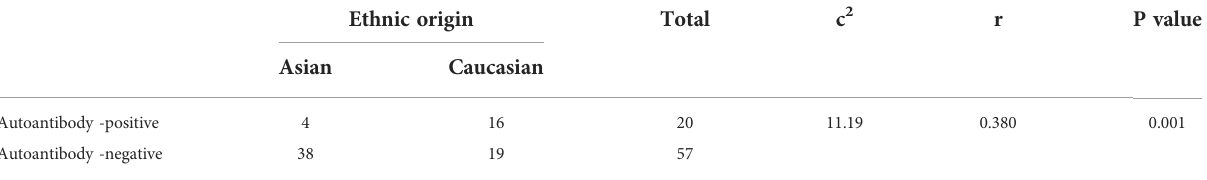
TABLE 2 Correlation analysis of autoantibody and ethnic origin in IFD.